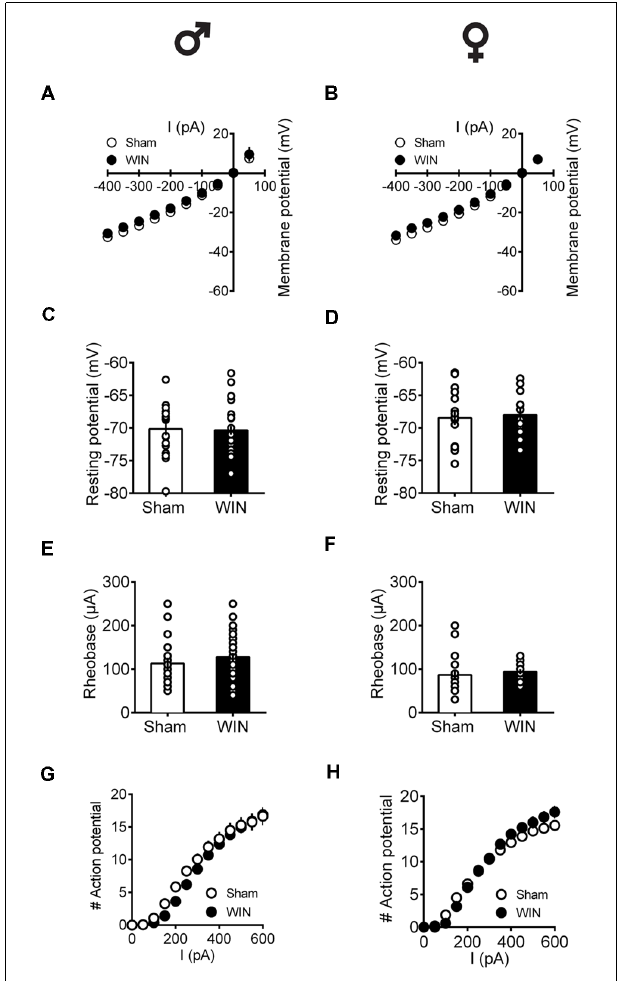
FIGURE 7 | Intrinsic properties of PFC pyramidal neurons are not altered by single in vivo exposure to cannabinoid in pubescent rats. Rats received a single administration of WIN55,212-2 (WIN, 2 mg/kg, s.c.) 24 h before. FIGURE 8 | Sex-specific alteration of pyramidal neurons’ intrinsic properties Current–voltage plot from visually identified pyramidal neurons recorded from in adult rats 24 h following single in vivo cannabinoid administration. Rats pubescent rats showing similar cell voltage in response to current steps received a single administration of WIN55,212-2 (WIN, 2 mg/kg, s.c.) 24 h between Sham and WIN of both male (A) and female (B) groups. No change before. Current–voltage plot from visually identified pyramidal neurons was observed in the resting membrane potential 24 h after WIN treatment in recorded from adult rats showing no difference in cell voltage in response to both male (C) and female (D) pubescent rats. Quantification of neuronal current steps between Sham and WIN groups of adult male rats (A) . In spiking properties indicated no change in the rheobase of either males (E) or contrast, membrane potentials were altered in adult WIN-treated females females (F) 24 h after single WIN. The number of evoked action potentials in compared to control group (B) . The resting membrane potentials were similar response to increasing depolarizing current steps was similar in Sham and to that of control in adult males (C) and females (D) 24 h following single WIN WIN-treated male (G) and female (H) pubescent rats. Males: Sham, exposure. Quantification of neuronal spiking properties showed no change in n = 15 cells/6 rats; WIN, n = 28 cells/10 rats. Females: Sham, the rheobase of males (E) , but a marked reduction in the female WIN-treated n = 17 cells/7 rats; WIN, n = 13 cells/7 rats. Scatter dot plot represents one group (F) . The number of evoked action potentials in response to increasing cell. Data represent mean ± SEM. Males; Females. depolarizing current step was similar in Sham and WIN-treated males (G) . In ♂ ♀ contrast, females showed a higher number of action potentials 24 h after WIN treatment (H) . Male: Sham, n = 16 cells/6 rats; WIN, n = 12 cells/5 rats; Female: Sham, n = 16 cells/6 rats; WIN, n = 20 cells/7 rats. Scatter dot plot represents one cell. Data represent mean ± SEM. ∗ p < 0.05, Mann-Whitney test (B), Bonferroni’s multiple comparisons test (F). Males; Females. ♂ ♀